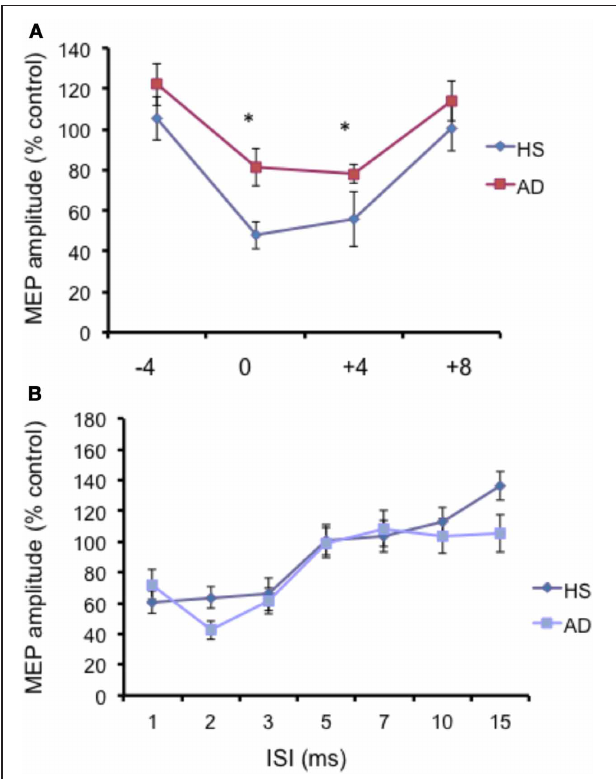
FIGURE 2 | (A) Short-latency afferent inhibition (SLAI) at different interstimulus intervals in AD patients (open squares) and control (black diamonds) subjects. The interval between median nerve stimulation and cortical stimuli was corrected for the latency of the N20 component of the somatosensory evoked potential in each subject (see text). The size of MEPs is expressed as a percentage of the MEP evoked by magnetic stimulation alone. (B) Short intracortical inhibition (SICI) and intracortical facilitation (ICF) at different interstimulus intervals in AD patients (open squares) and control subjects (black diamonds). The size of MEPs is expressed as a percentage of the MEP evoked by magnetic stimulation alone. Error bars indicate mean standard errors. ∗ p < 0 .